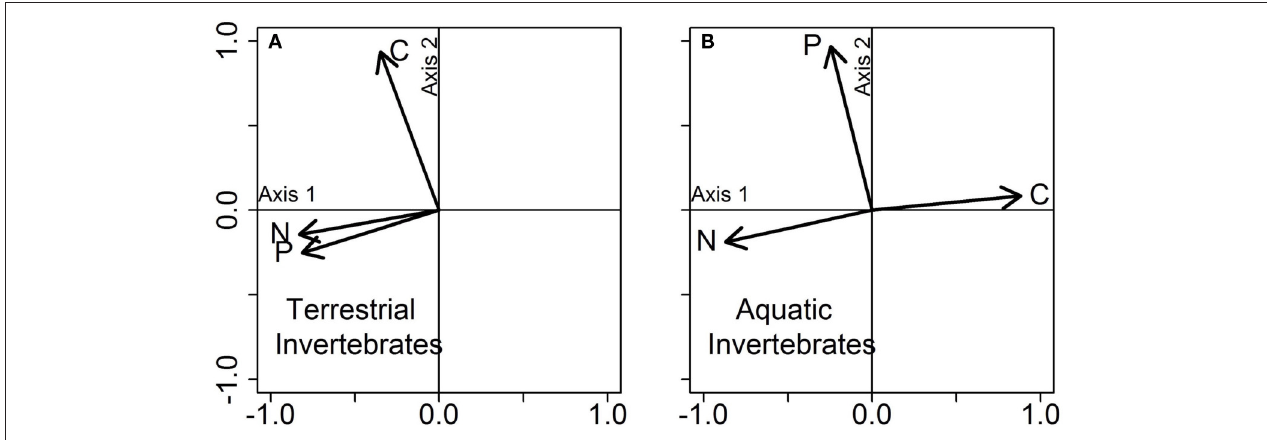
FIGURE 4 | PCA on the stoichiometric traits of (A) terrestrial and (B) aquatic food webs (only invertebrates included). Each plot represents a PCA conducted separately for each group of organisms, using the data displayed jointly in Figure 3 . Vectors show the influence of the three stoichiometric traits (C, N, and P contents) on each PCA axis.